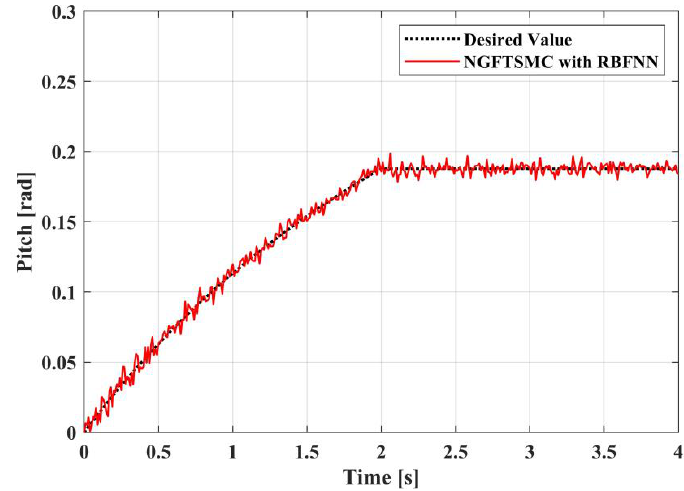
Figure 20. The experimental results in roll angel.